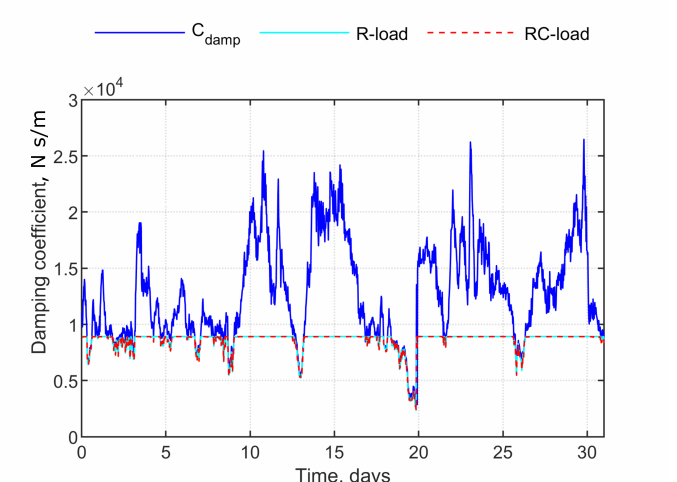
Figure 15. The maximum damping coefficient, calculated by different approaches for the buoy with a radius of 1